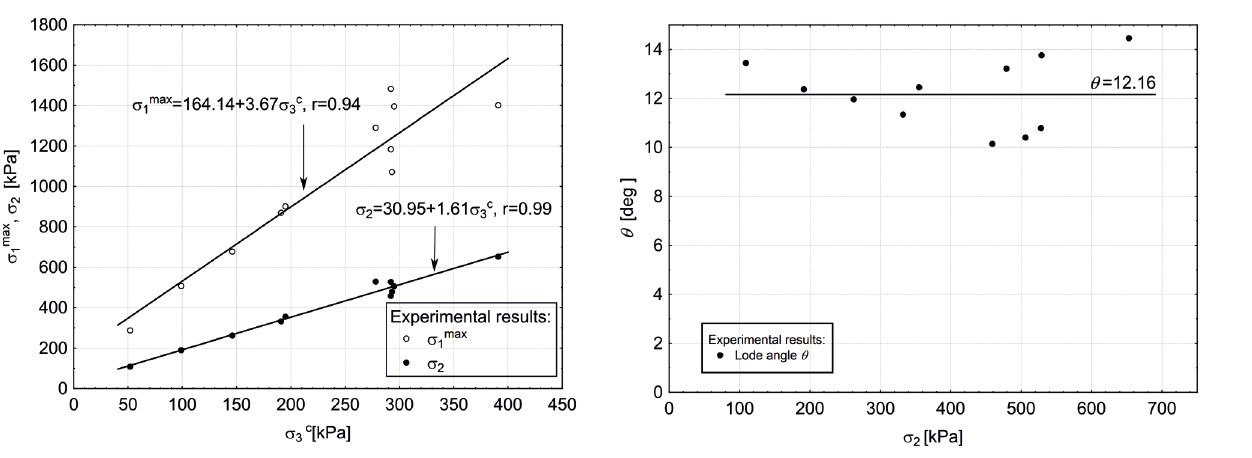
Figure 13: Relation between Lode angle q and intermediate stress s